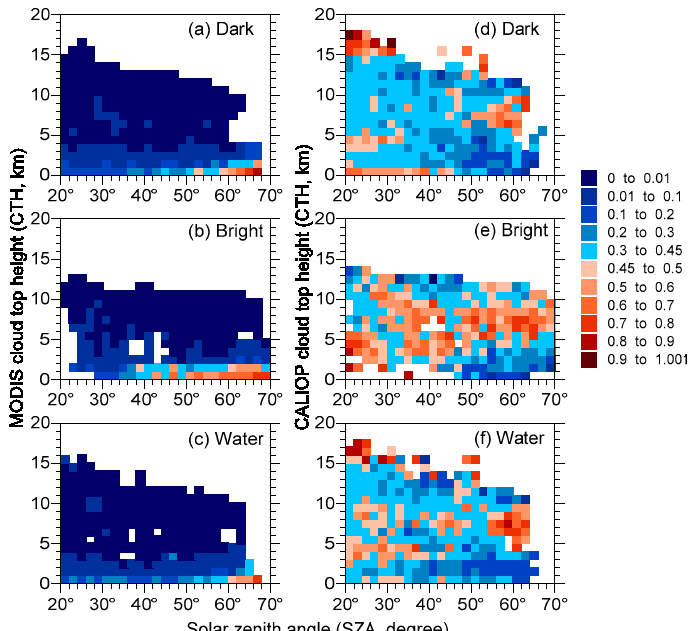
Figure 3. The r_MODalone as a function of solar zenith angle (SZA) and MODIS cloud top height (CTH) over ( a ) dark, ( b ) bright, and ( c ) water surfaces, and the r_CALalone as a function of SZA and CALIOP CTH over ( d ) dark, ( e ) bright, and ( f ) water surfaces.